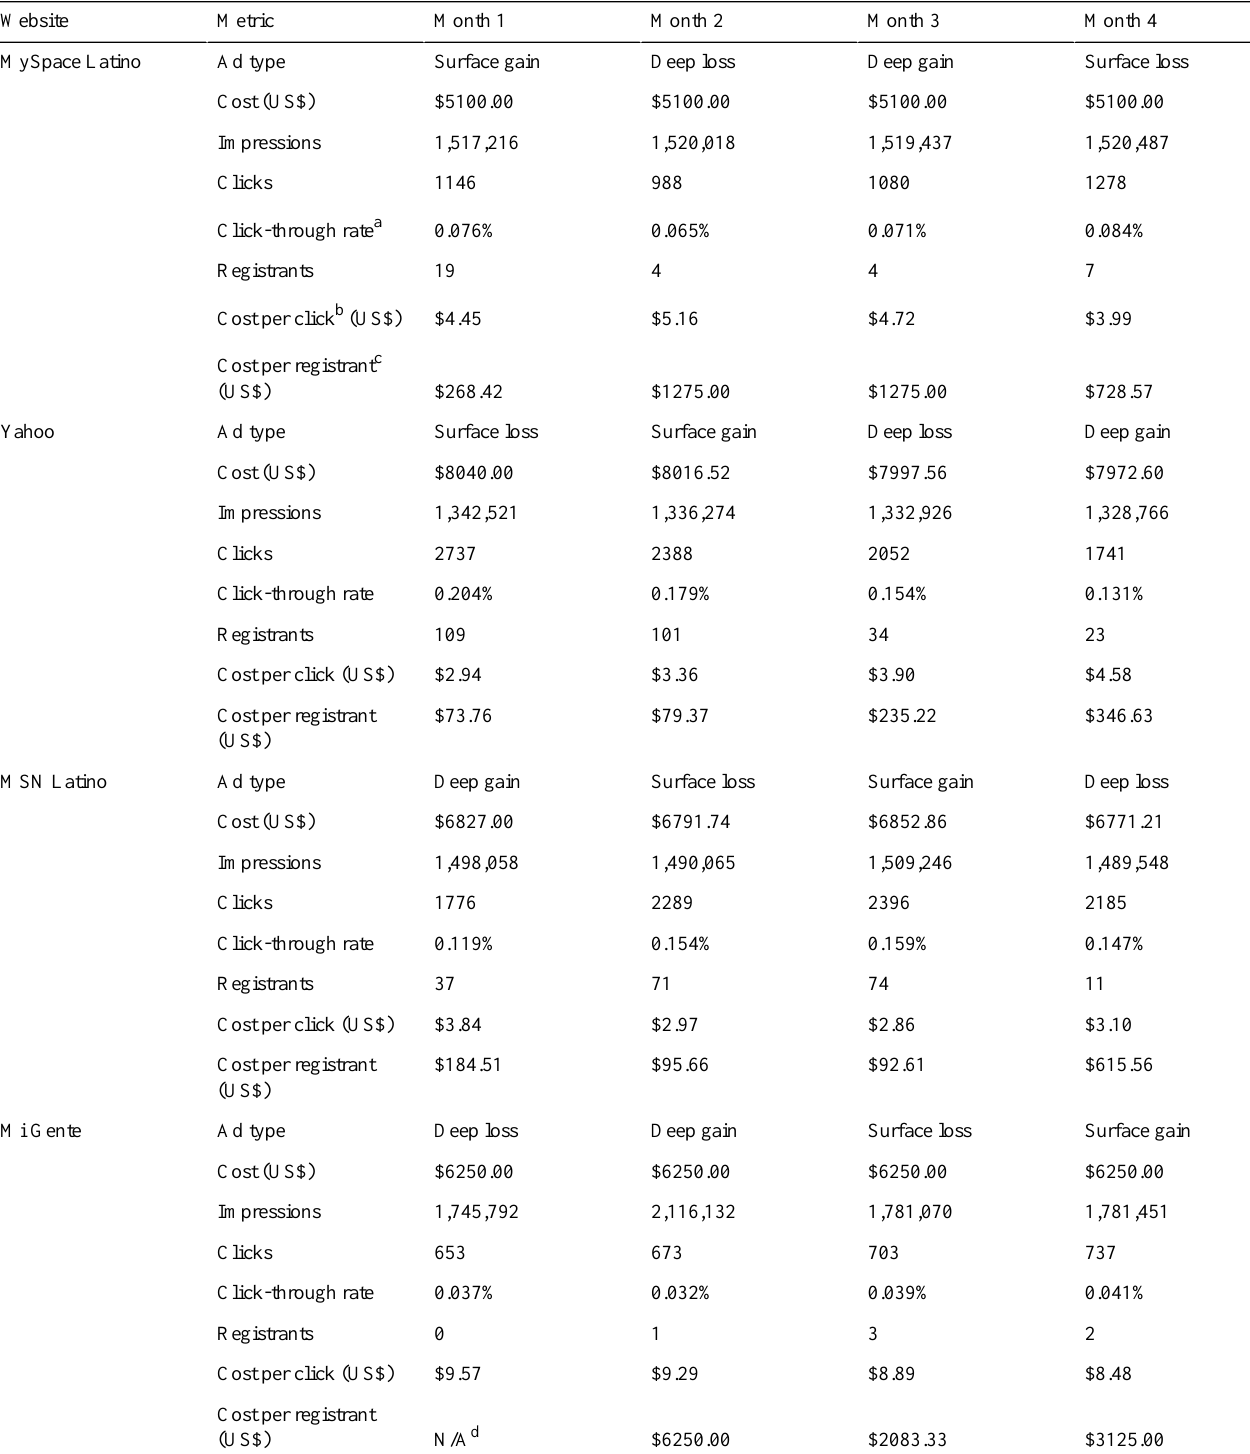
Table 1. Overview of Latin square design and overall banner ad performance by website placement and time.